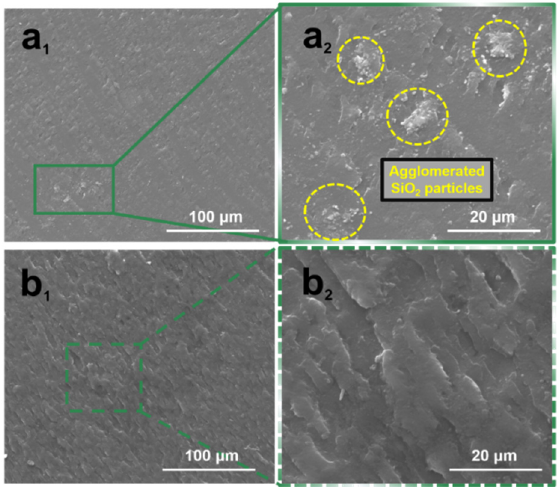
the interface between the SiO 2 particles and the PMMA matrix. Both SEM and TEM tests indicate that Si-DPF is able to effectively prevent nano-SiO 2 particles from aggregating.